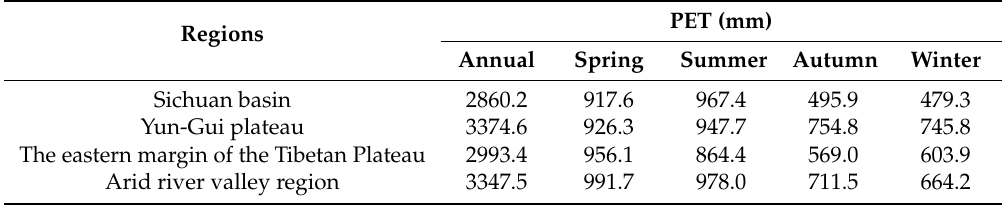
Table 1. Annual and seasonal PET estimated by FAO–PM method in the four sub-regions. PET (mm) Regions Annual Spring Summer Autumn Winter Sichuan basin